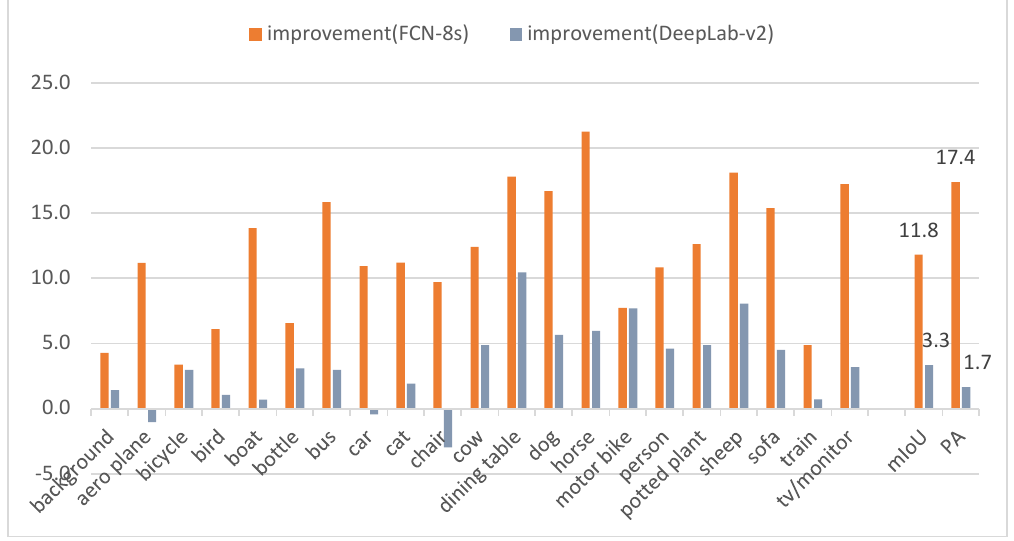
Figure 13. The improvement by our method compared with FCN-8s and DeepLab-v2.